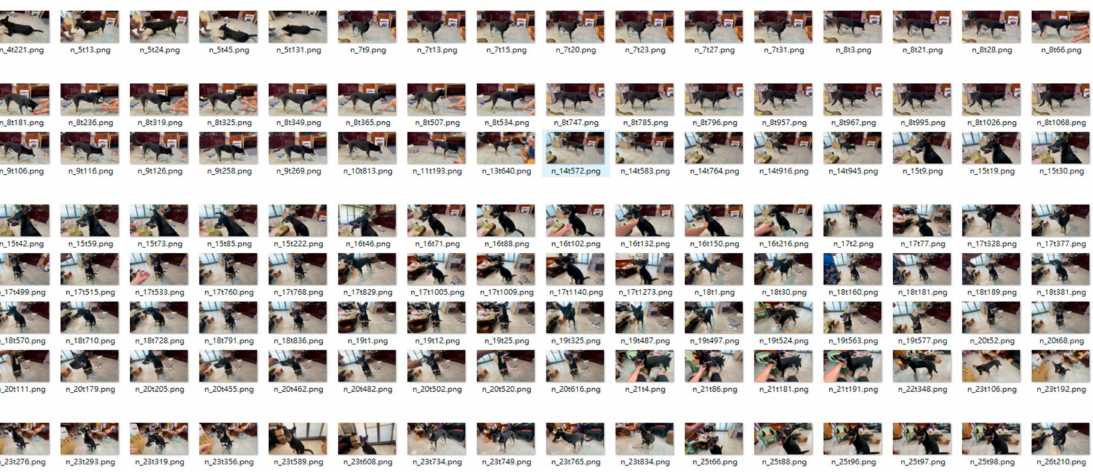
Figure 6. Training samples.